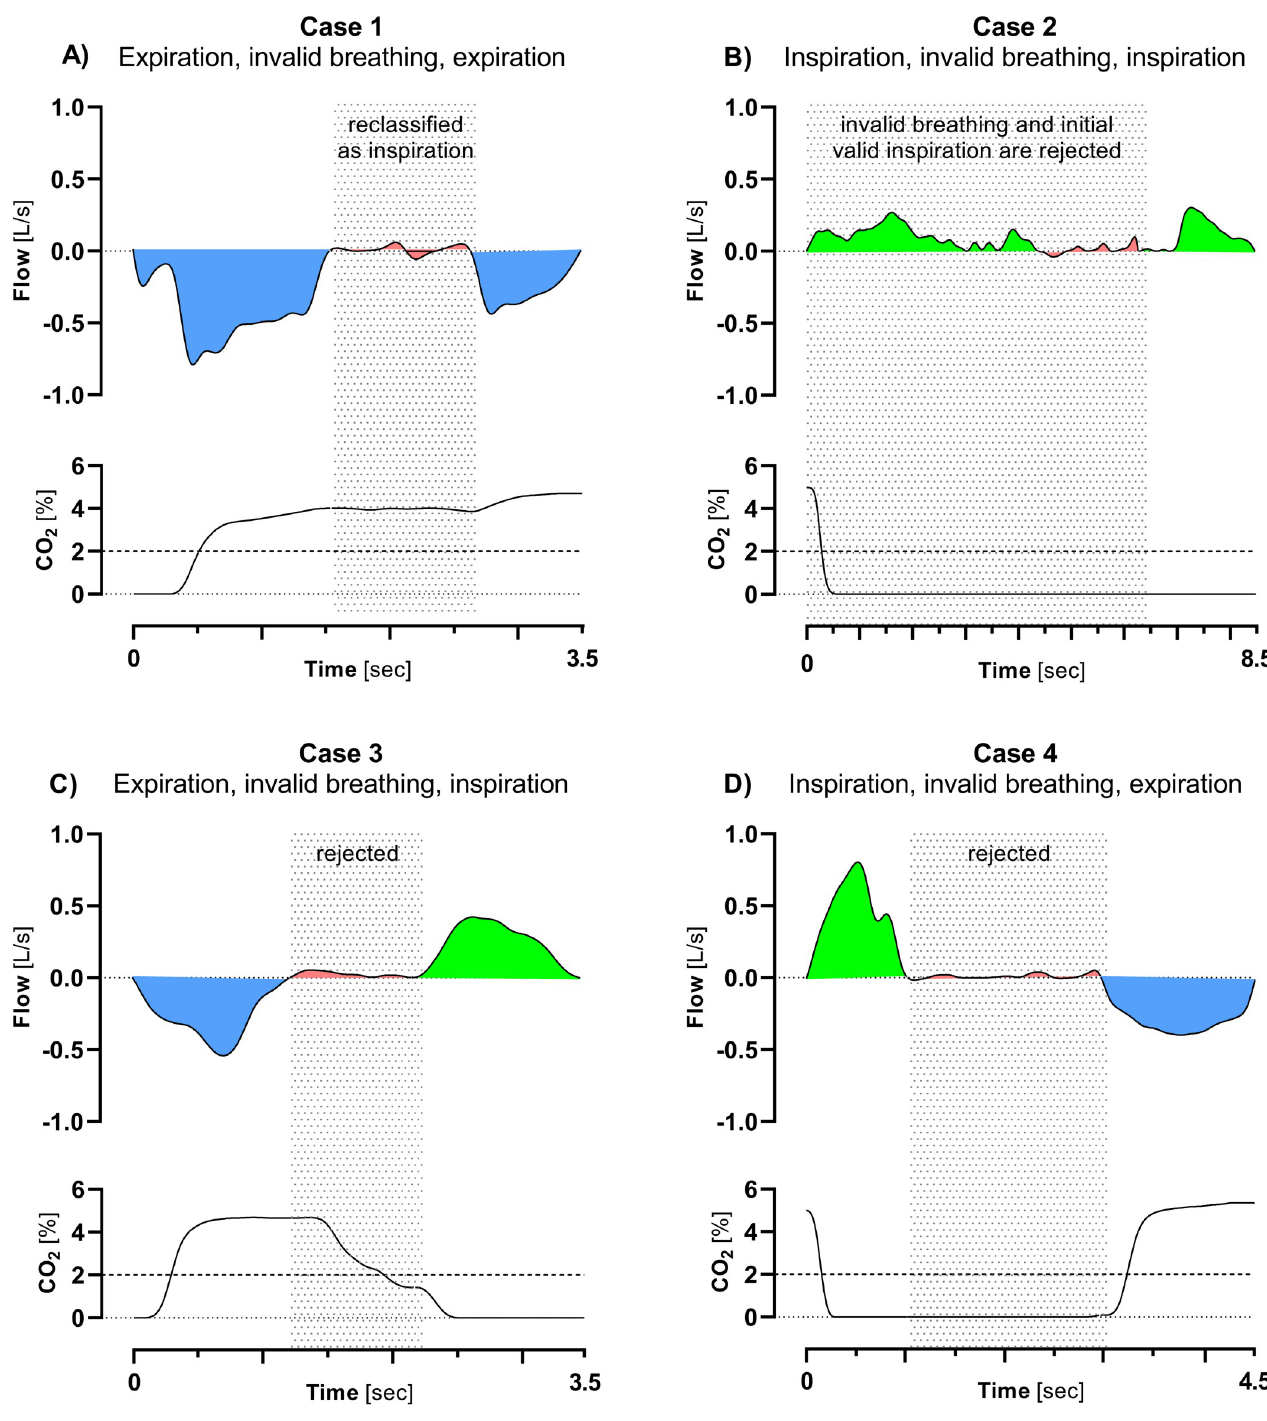
Fig 1. Invalid breathing as detected by Spiroware analysis software. Shown are flow and carbon dioxide traces of intervals of inspirations, expirations, and invalid breathing before re-classification (A) or rejection (B, C, D). The shaded areas indicate reclassified intervals. Blue area: expiration; red area: invalid breathing; green area: